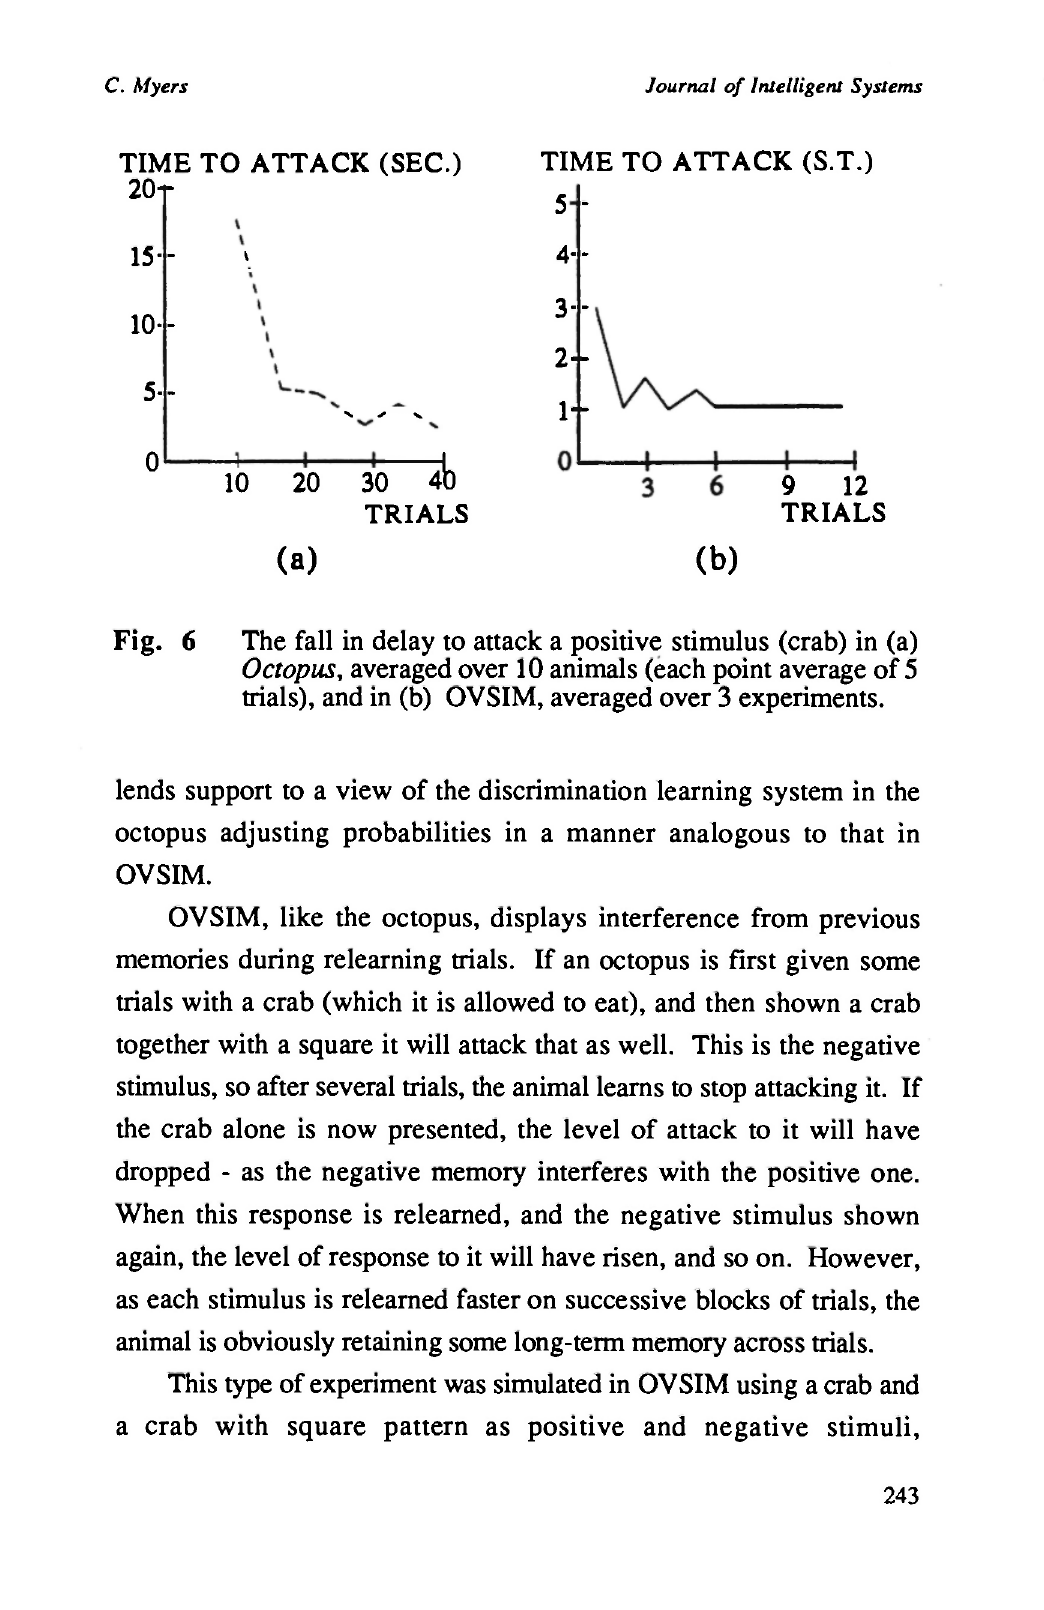
The fall in delay to attack a positive stimulus (crab) in (a) Octopus, averaged over 10 animals (each point average of 5 trials), and in (b) OVSIM, averaged over 3